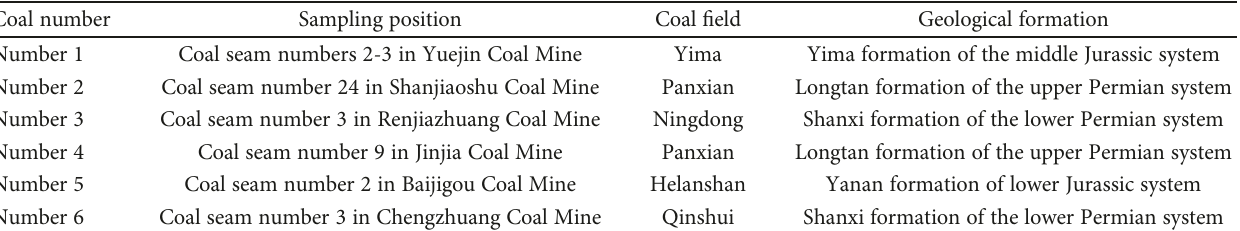
Table 1: Geological information of coal seams where the samples were collected.